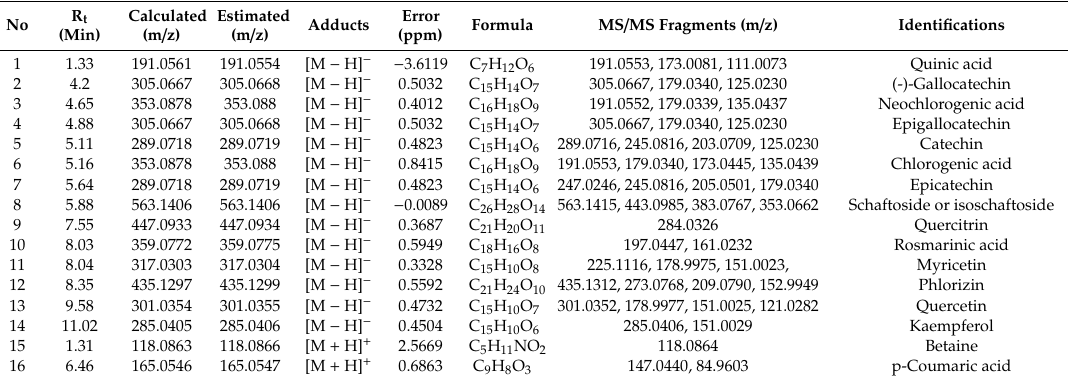
Figure 5. UHPLC-MS / MS analysis of WELC. ( A ) Ultraviolet and base peak chromatograms of WELC. ( B ) Extracted ion chromatograms of the identified components in WELC. UHPLC–MS / MS, ultra-high-performance liquid chromatography-tandem mass spectrometry; WELC, water extract of Lysimachia christinae . Table 1. List of identified components in WELC by UHPLC-MS / MS